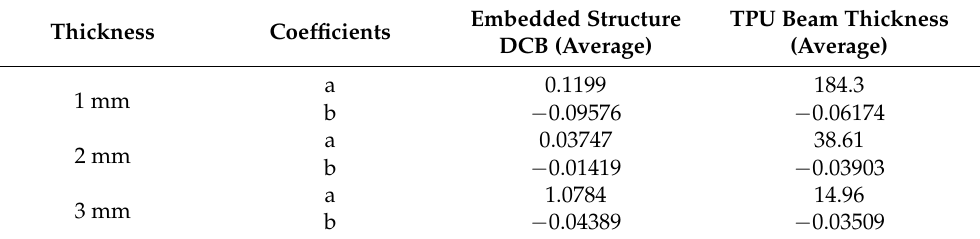
Table 9. Coefficients for DCB with an embedded TPU capsule and simple TPU beam, for three beam